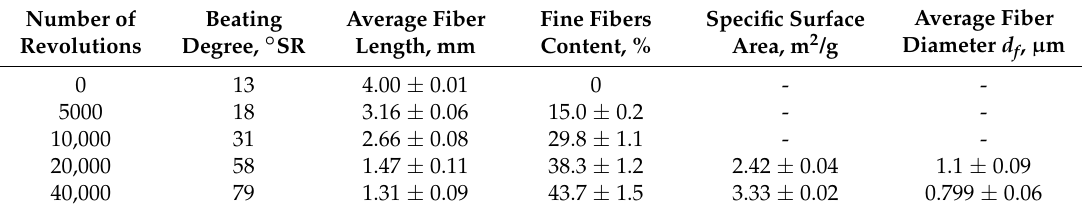
Table 2. Properties of fibrillated fibers under different